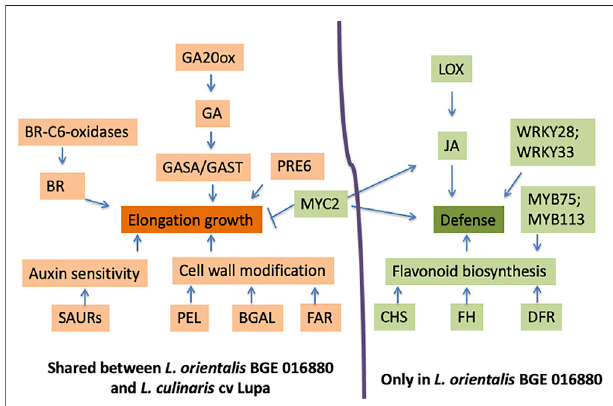
FIGURE 5 | Model for roles and interactions of genes on elongation growth and defense response under low R/FR-induced shade conditions for both L. orientalis BGE 016880 and L. culinaris cv. Lupa. This model summarizes the major results from this study, and the hypothetical interactions are based on previous network studies on Arabidopsis and other crops (Carriedo et al., 2016; Ballaré and Pierik, 2017; Fernández-Milmanda and Ballaré, 2020). Arrows indicate a promoting interaction, and a T-end indicates an inhibiting interaction. Genes/biological processes in orange refer to upregulation, while green refers to